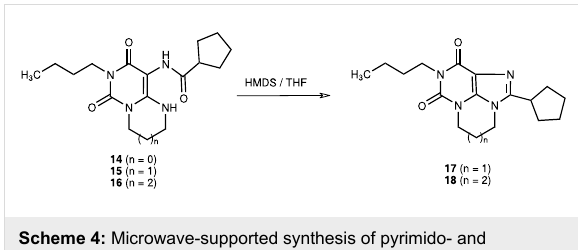
Scheme 4: Microwave-supported synthesis of pyrimido- and diazepino-purinediones